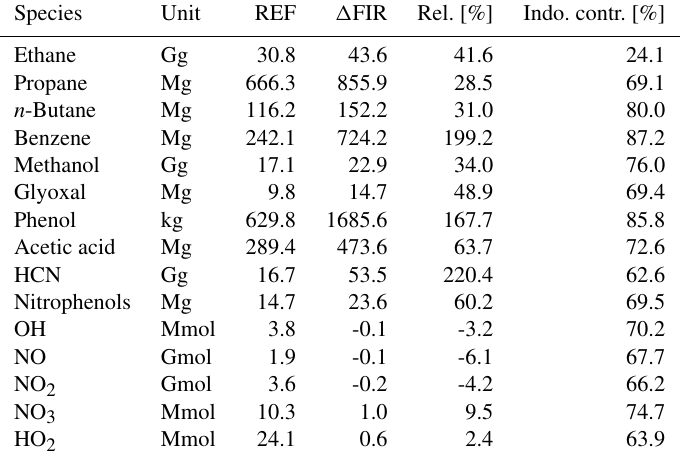
Table 4. Stratospheric burden in November 2015 and changes induced by VOC biomass burning emissions. In addition, the relative difference (Rel.) and the Indonesian contribution (Indo. contr.) are shown. The latter is calculated based on the difference of FIR and FIR NOINDO . Species Unit REF (cid:49)